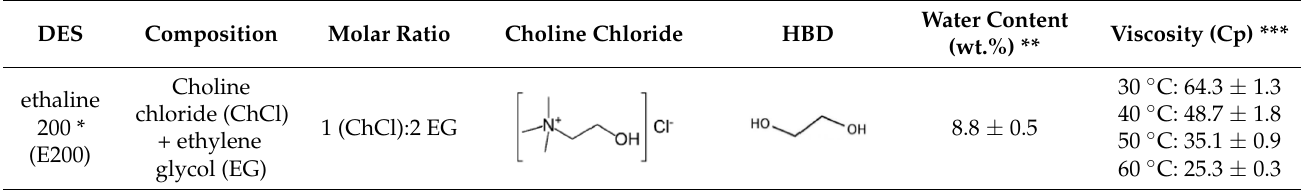
* Trade name, ** measured at room temperature, right after the DES preparation *** measured between 30–60 °C, right after the DES preparation.